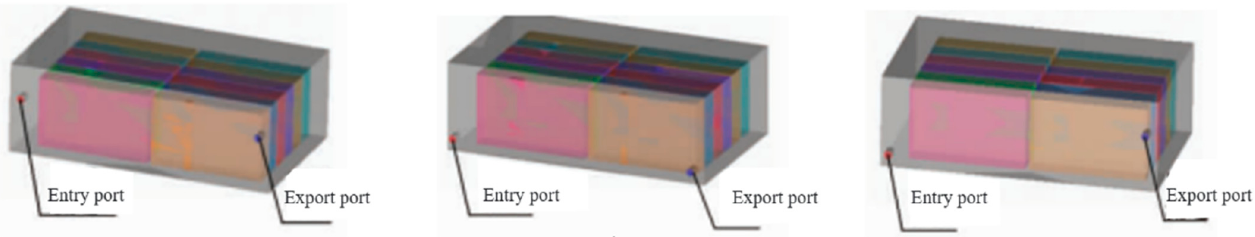
Figure 8. Three “U”-shaped runner structures [64].